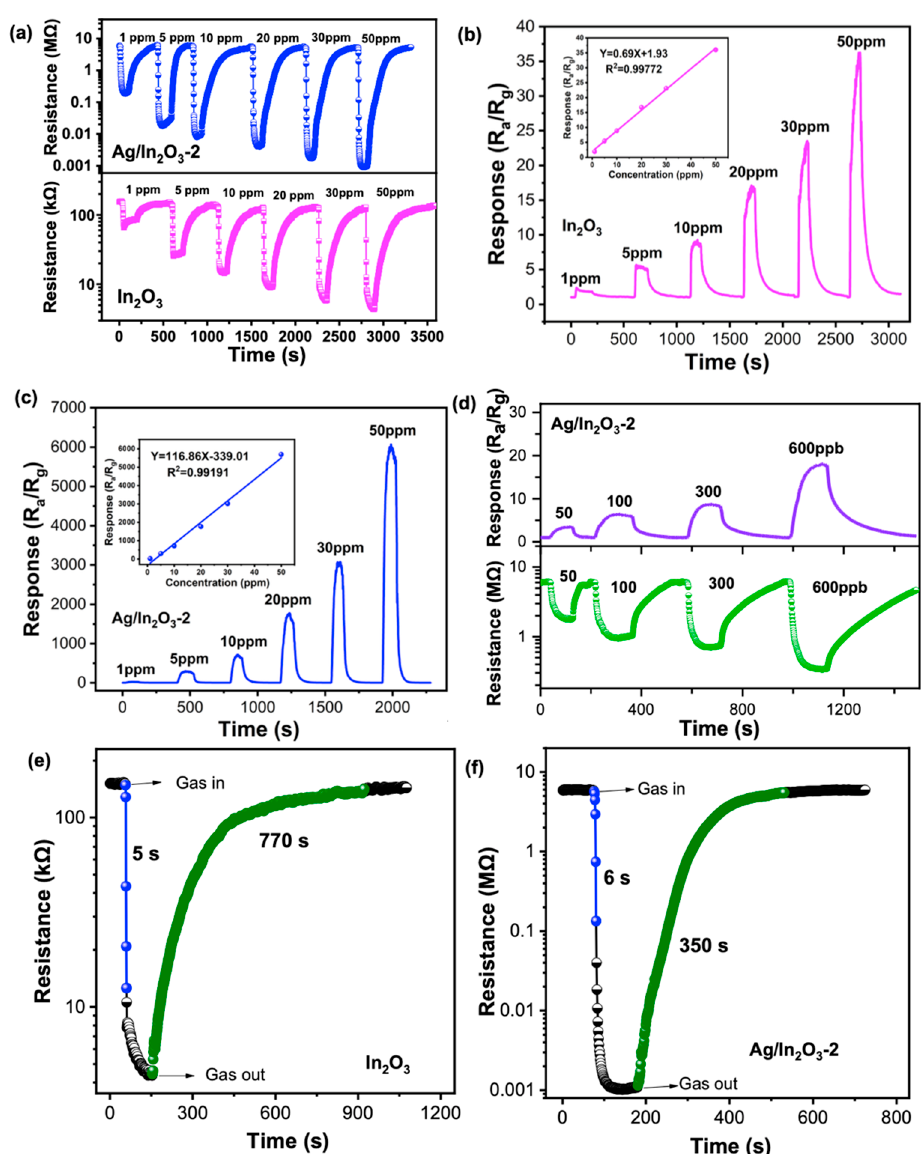
Figure 6. ( a ) Dynamic resistance change in In 2 O 3 and Ag/In 2 O 3 -2 as exposure to 1 ‒ 50 ppm TEA at 300 °C. Real-time response–recovery curve of ( b ) In 2 O 3 and ( c ) Ag/In 2 O 3 -2 for 1 ‒ 50 ppm TEA at 300 °C (the insets are their corresponding liner relationship between response and gas concentration.).